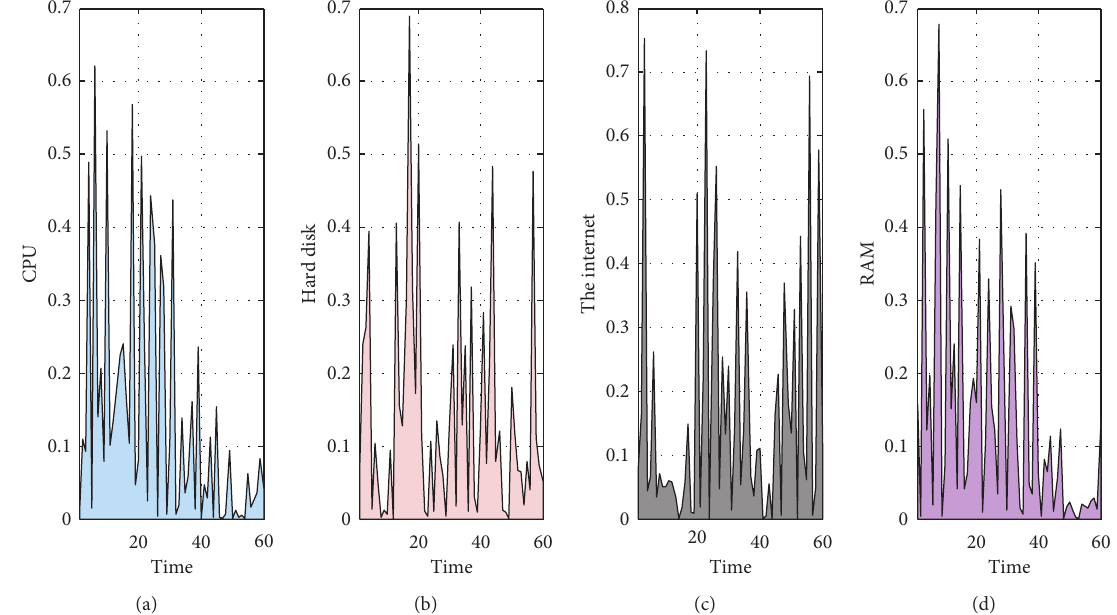
Figure 8: Visual comparison of multithreaded resource